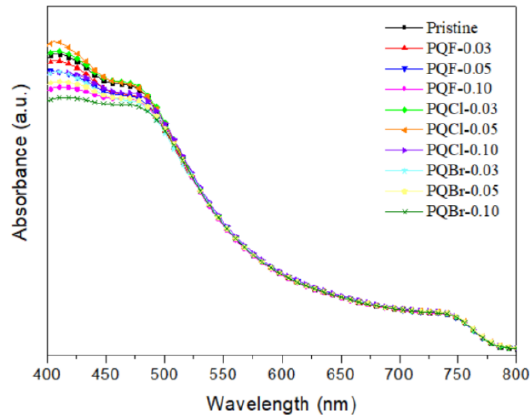
Figure 9. UV–Vis absorption spectra of MAPbI 3 films deposited on cellulose derivative–modified NiO x layers.